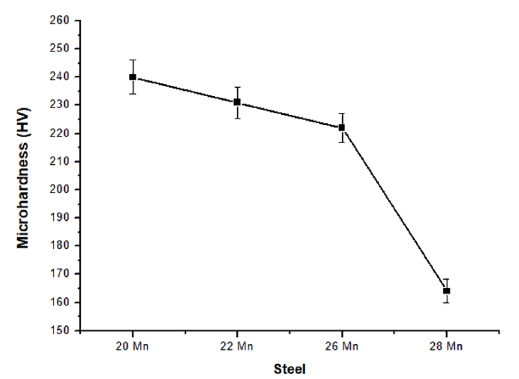
Figure 9. Microhardness of high manganese steels. Source: